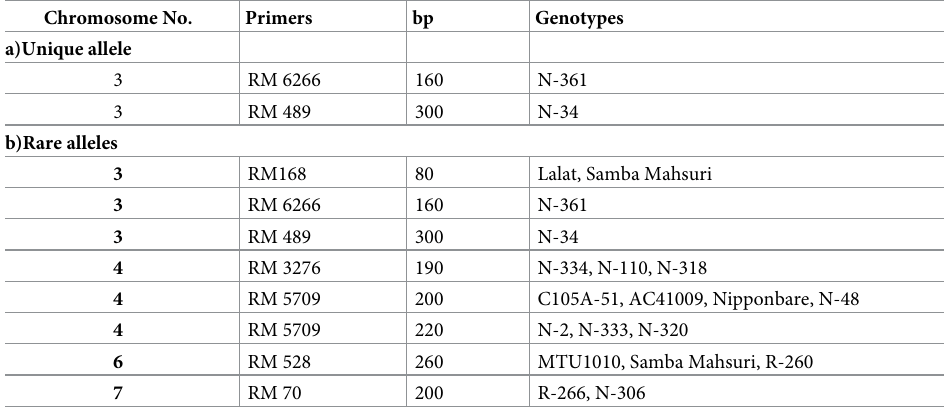
Table 2. Unique and rare alleles amplified by microsatellite loci in different rice genotypes. Chromosome No. Primers bp Genotypes